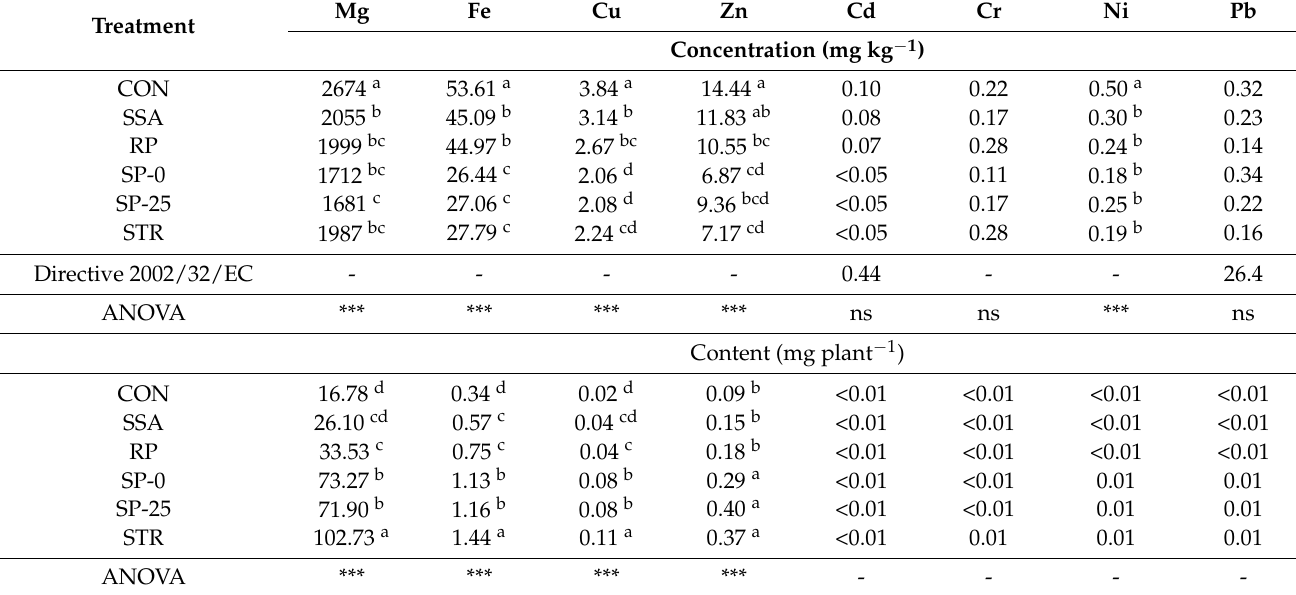
Table 6. Mean concentration (mg kg − 1 ) and contents (mg plant − 1 ) of magnesium (Mg), iron (Fe), cupper (Cu), zinc (Zn), cadmium (Cd), chromium (Cr), nickel (Ni) and lead (Pb) in maize aboveground biomass. The same letters indicate no significant differences between the treatment (n = 4, Tukey ´ s HSD test ( α = 0.05)). Analysis of Variance (ANOVA): *** = p ≤ 0.001, ns = not significant ( p > 0.05). For fertilizer abbreviations, see Table 1.